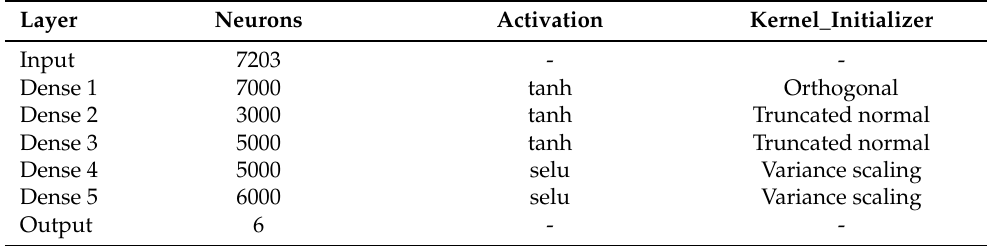
Table 3. ANN architecture for the biaxial test.